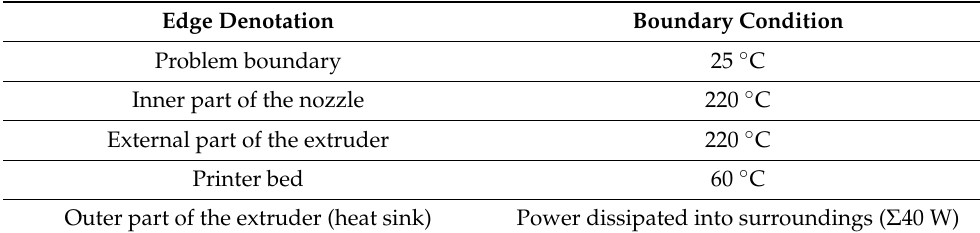
Table 1. Boundary conditions of the static model.